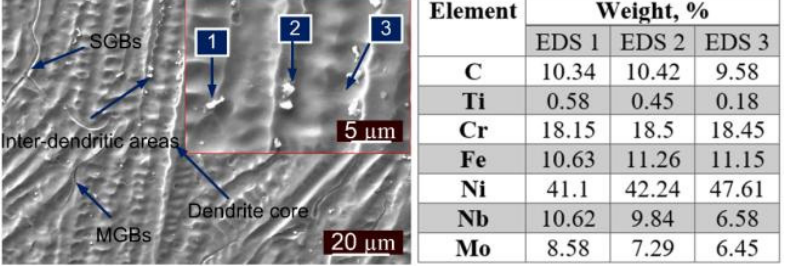
Figure 11. Elemental profile at the interface of ( a ) P22 steel and ERNiCrMo-3 weld metal, ( b ) P91 steel and ERNiCrMo-3 weld metal for AW joint; ( c ) P22 steel and ERNiCrMo-3 weld metal after the PWHT.